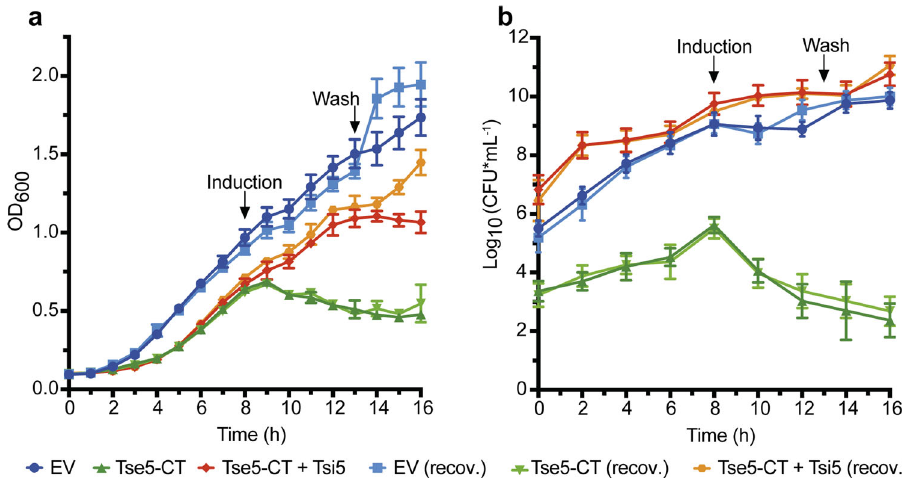
Fig. 1 Tse5-CT has a bacteriolytic effect when expressed in P. putida . a Monitoring growth (OD 600 ) in LB medium of P. putida cells harbouring pS238D1 empty vector (EV) as a negative control or plasmids directing the expression of Tse5-CT, or Tse5-CT and Tsi5 together. Expression of Tse5-CT and Tsi5 was induced after 8h of bacterial growth (see the arrow) with 1mM m-Toluic acid (TA) and 0.1 mM isopropyl 1-thio- β - D -galactopyranoside (IPTG), respectively. Co-expression ofTse5-CTand Tsi5was induced byadding tothemedia bothTAand IPTG. To stop the induction,the recovered cells (recov.)were washedand resuspended in fresh LB without inductors (see the arrow). Expression of Tse5-CT caused inhibition of bacterial growth, and cells did not recover the capacity to duplicate after washing. Tsi5 confers cell protection from Tse5 expression. b Monitoring growth on solid medium. Samples of P. putida growing cells were taken every 2h, and dilutions were spotted on LB agar plates. Colony-forming units (CFU) were counted 24h later. All measurements were made in triplicate ( n = 3 biological replicates). The graphs show the mean values and ± standard deviations (SD). Some error bars are not visible due to overlaps with